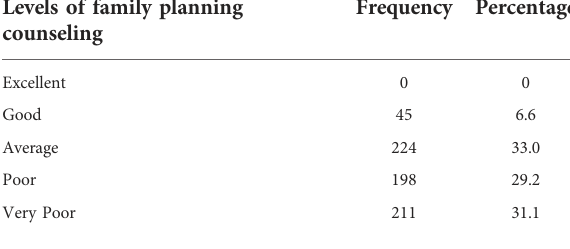
TABLE 3 Levels of family planning counseling quality among women attending family planning services at health facilities in Akaki Kality sub-city, Addis Ababa, Ethiopia, 2020 ( N